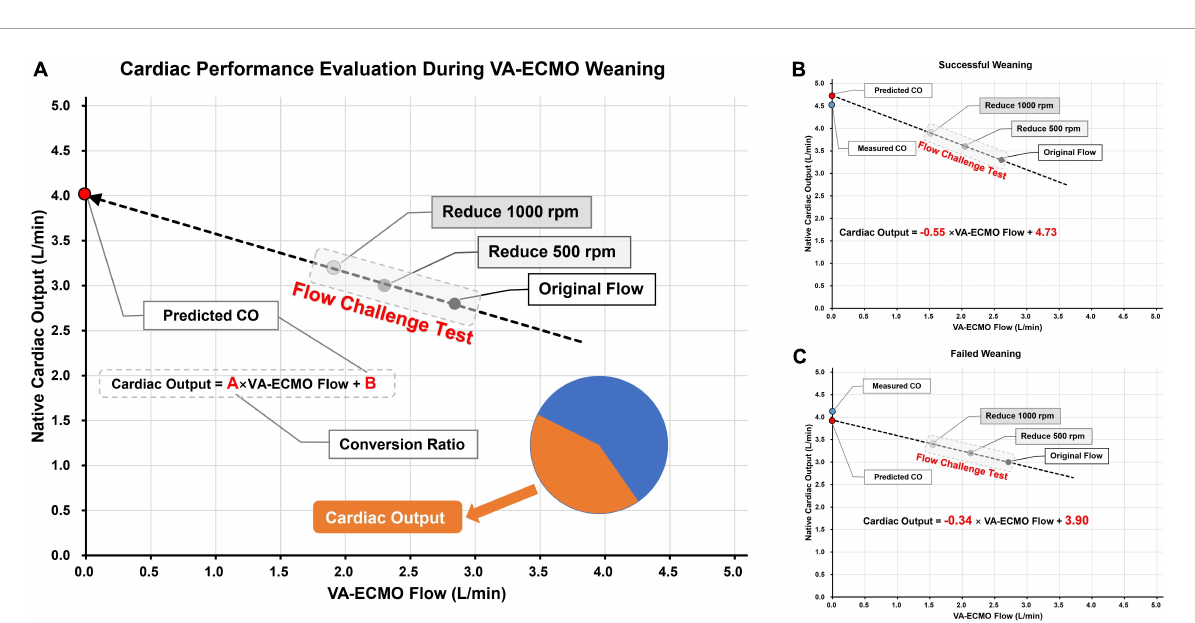
FIGURE2 Schematic diagram of using flow challenge test (FCT) to predict cardiac output (CO) performance after V-A ECMO weaning. Panel (A) the picture on the left is the schematic diagram of FCT; The pump speed was reduced on two stages, each time by 500 rpm. CO were measured at the corresponding three points and the actual ECMO flow rates were also recorded. The CO after weaning was then predicted by linear regression and the conversion ratio between ECMO blood flow and CO was calculated. Panels (B,C) two cases of successful and failed weaning, respectively. The predicted and actual values of CO are very close to each other. The weaning successful patient shown higher predicted CO and conversion ratio than the weaning failure patient.